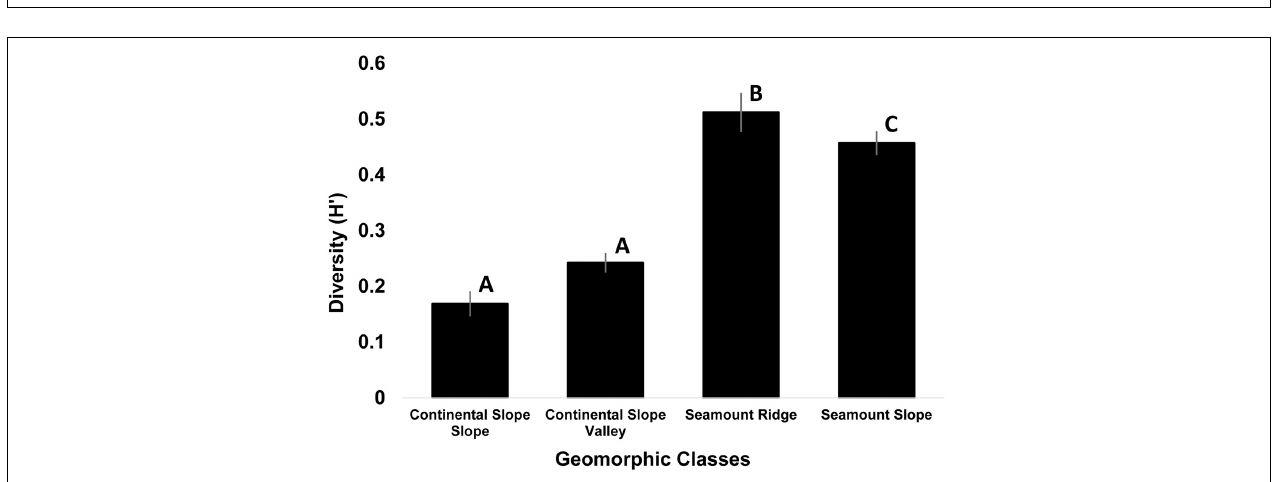
FIGURE 4 | Mean taxonomic richness, abundance, diversity (H (cid:48) ), and evenness (J (cid:48) ) for segments within canyons ( n = 533) and segments on seamounts ( n = 572). Error bars are standard error. Asterisks denote significant differences.